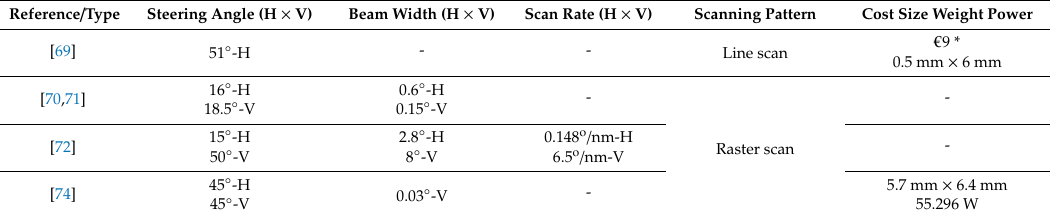
Table 4. Comparison of performance and SWaP specifications for selected optical phased array (OPA) scanners.